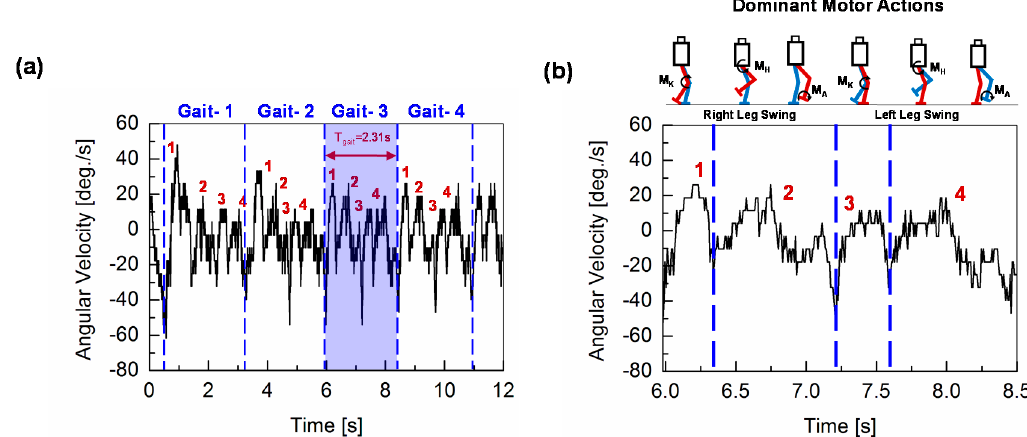
Figure 5. ( a ) Angular-pitch velocity of the robot torso when the robot walks on an uninclined surface ( φ = 0 ◦ ). ( b ) The angular-pitch velocity of the third gait cycle as detected by the gyro sensor. The third gait cycle is shown in an expanded form, to explain the gait pattern of the robot on the uninclined surface. Peaks 1 and 2 are due to the positive angular-pitch velocity for the first half of the cycle (right-leg swinging phase), and peaks 3 and 4 are observed in the second half of the cycle (left-leg swinging phase). These four peaks are observed to be the characteristic feature of one gait cycle.